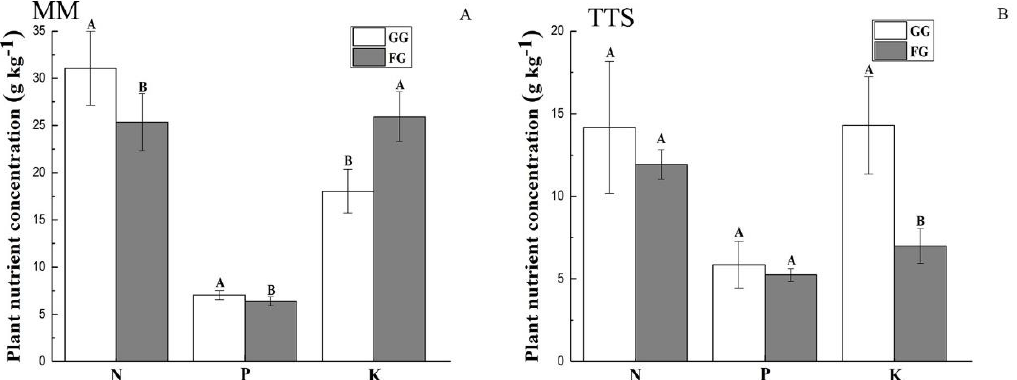
Figure 6. Plant nutrient concentrations in the MM and TTS under the grazing and fencing treatments. ( A ): Plant N, P and K concentrations under the grazing and fencing treatments in MM; ( B ): Plant N, P and K concentrations under the grazing and fencing treatments in TTS. Values are the means ± standard deviation, the bar charts marked with di ff erent capital letters on the top of the column are significantly di ff erent ( p < 0.05). MM: mountain meadow; TTS: temperate typical steppe; GG: grazed grassland; FG: fenced grassland.